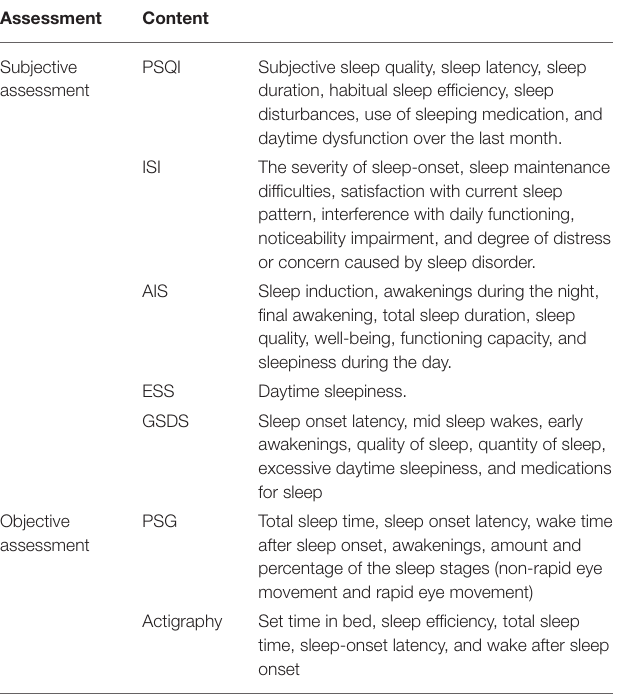
TABLE 1 | The common assessments of